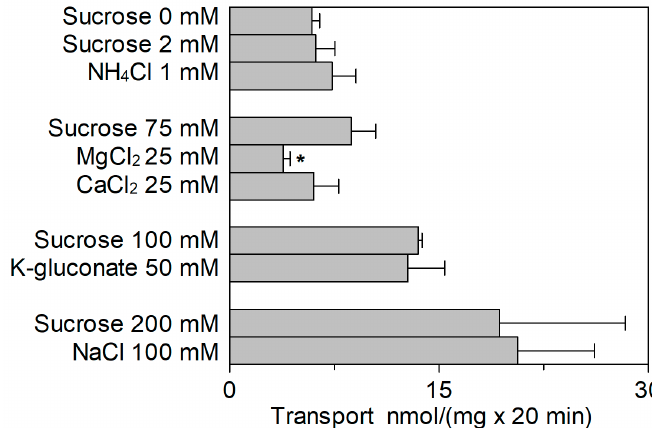
Figure 7. Effect of intraliposomal cations on the transport activity of Sl CAT2. Sl CAT2 was purified and reconstituted in proteoliposomes as described in Section 4.4. Transport was measured in 20 min, as described in Section 4.5, by adding 100 µM [ 3 H]Arg to proteoliposomes containing indicated concentrations of sucrose or cations and 15 mM ATP, at pH 7.5. Concentrations were chosen according to the average concentrations of cations in the vacuolar lumen. Results are the means ± SD from four experiments. (*) Significantly different from the control (isoosmotic concentration of sucrose for each category of cations) for p < 0.05 as calculated from 1-way ANOVA test.